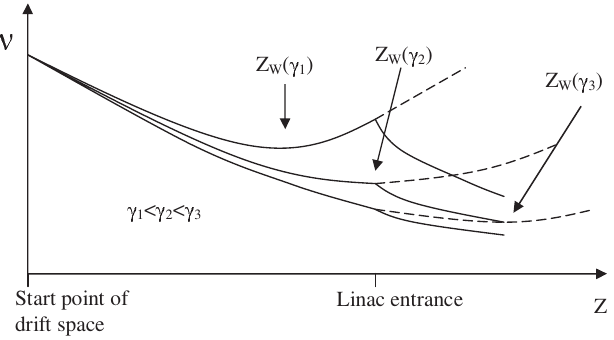
FIG. 10. The chromaticity in drift space. The waist position of the smaller energy slice is earlier and its beam is larger. The waist position of the higher energy slice is later, and its beam is smaller.